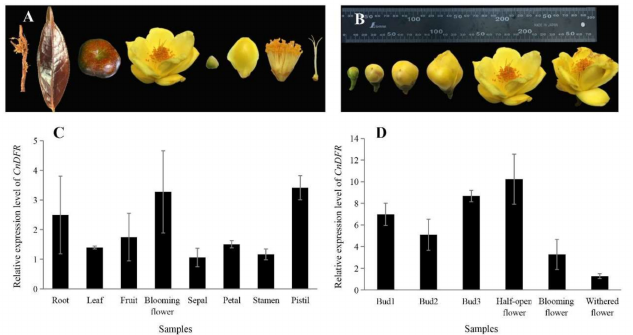
Figure 2. Relative expression level of CnDFR in C.nitidissima Chi. ( A ) Tissues of C.nitidissima Chi.: root, leaf, fruit, flower, speal, petal, stamen, pistil. ( B ) Flowers at di ff erent developmental stages of C.nitidissima Chi.: bud in 10 mm, bud in 20 mm, bud in 30 mm, half-open flower, blooming flower, withered flower. ( C ) Relative expression level of CnDFR in di ff erent tissues of C.nitidissima Chi. CnDFR expressed in all of the tissues, while the expression was the highest in the flower and the lowest in the sepal. ( D ) Relative expression level of CnDFR in flowers at di ff erent developmental stages. The expression of CnDFR showed a trend of first decreasing then increasing and then decreasing, and the expression was the highest in the half-open